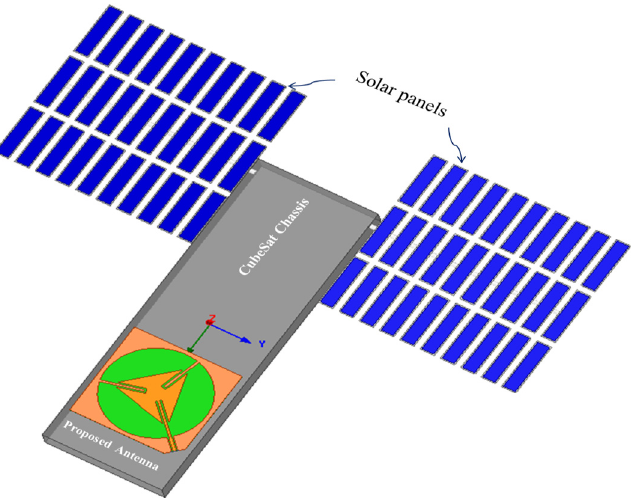
Figure 20. 3D HFSS model of the proposed full system (3U CubeSat + Slot antenna 4).